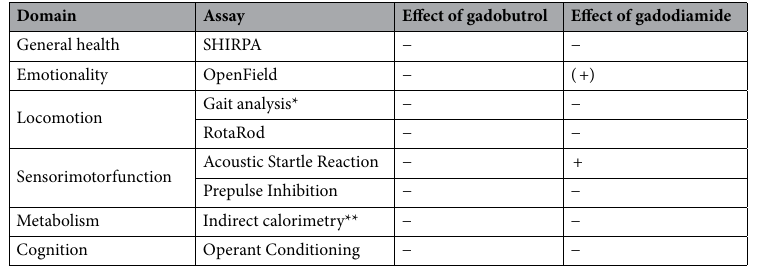
Table 1. Behavioral domains addressed, and respective behavioral tests performed. Observed effects are indicated by -: no effect observed; (+): effect observed, potentially confounded; + : effect observed (no confounding condition). *using the CatWalk XT system, **measured with the PhenoMaster